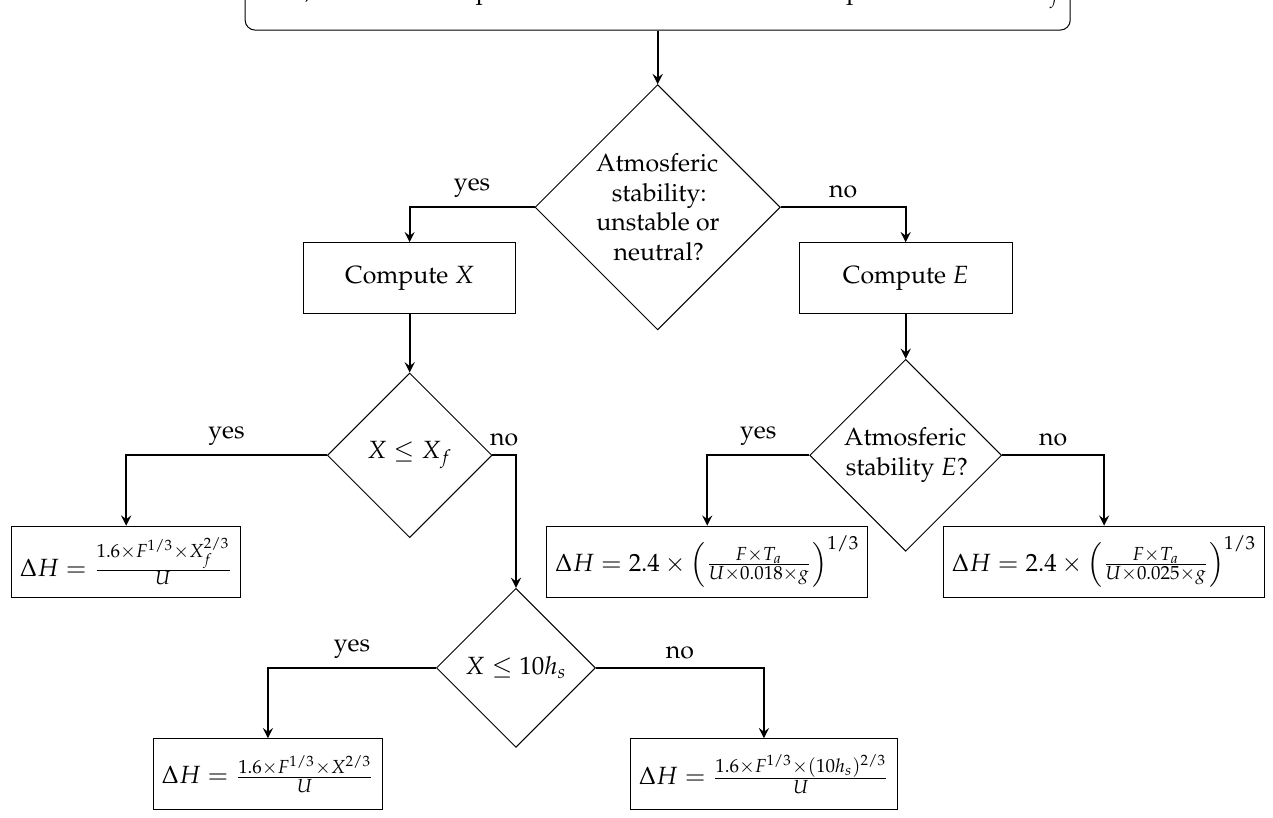
Figure 12. Decision algorithm for obtaining plume lift.